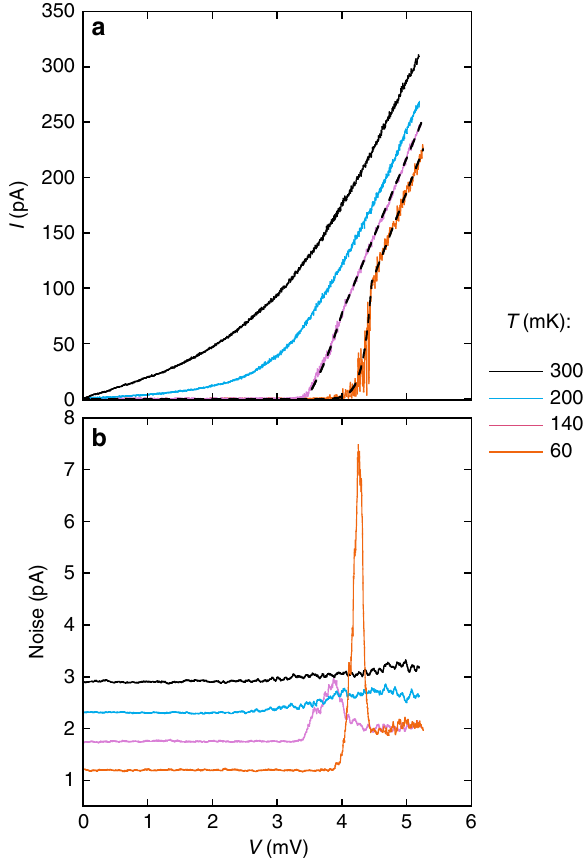
Fig. 3 Voltage-current characteristics and noise. a V − I characteristics at n = 5.36 × 10 10 cm − 2 for different temperatures. The dashed lines are fi ts s to the data using Eq. (5). b The broad-band noise as a function of voltage for the same electron density and temperatures. The three upper curves are shifted vertically for clarity